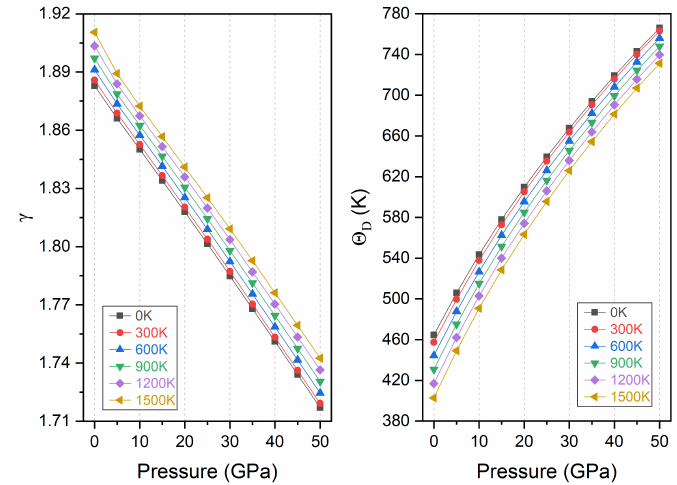
Figure 13. The Grüneisen constant ( γ ) and Debye temperature ( Θ D ) variation with pressure for Ti 2